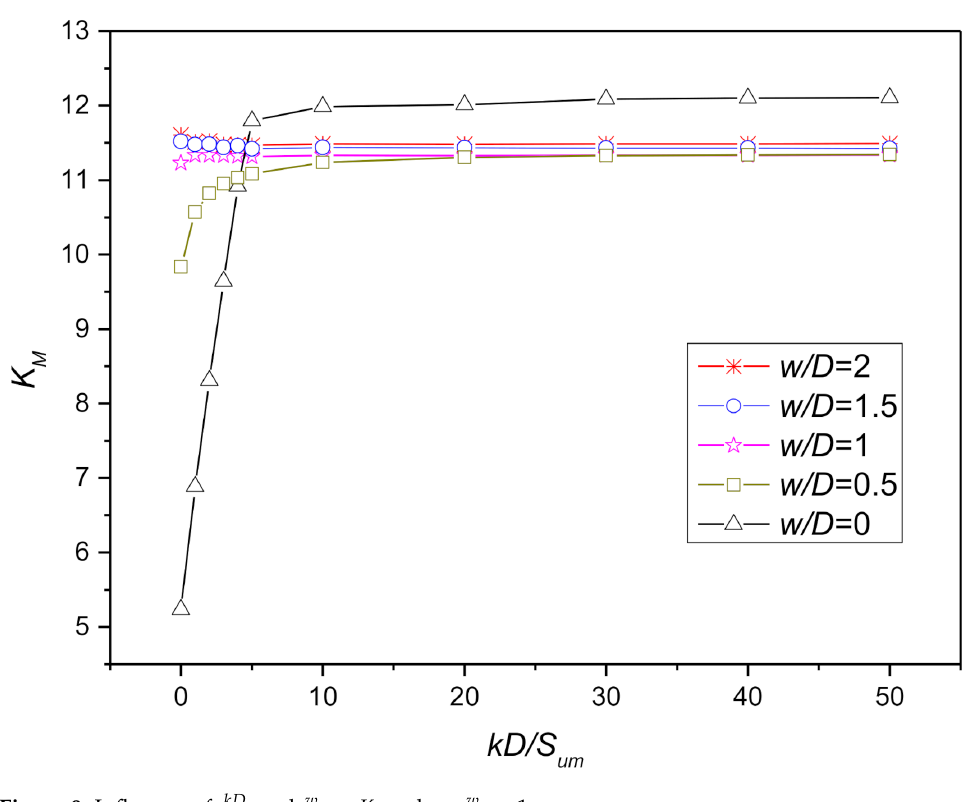
on K M when w and w D S um